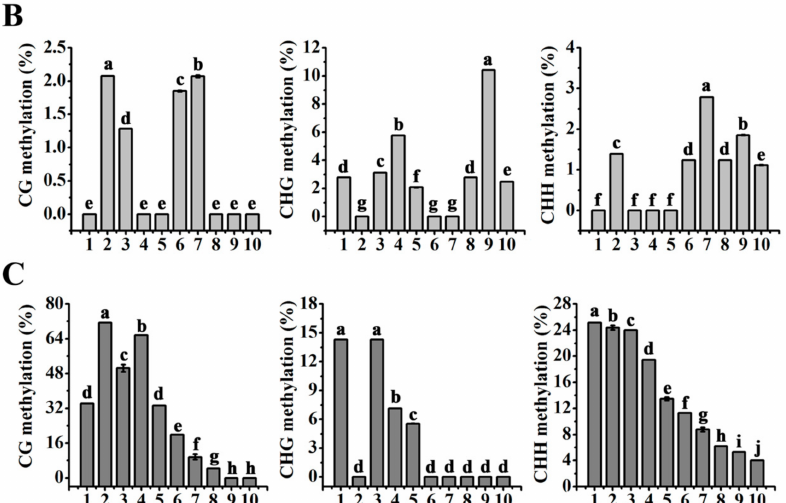
Figure 2. McCOP1 promoter methylation level in crabapple leaves. ( A ). The positions of BP1 and BP2 primers in the McCOP1 promoter. ( B ). McCOP1 promoter methylation level determined using the BP1 primers. ( C ). McCOP1 promoter methylation level determined using the BP2 primers. The numbers 1–10 represent different leaf growth stages. ( D ). Correlation between the McCOP1 promoter methylation levels and McCOP1 gene RNA expression profiles in crabapple leaves visualized as a heat map. Methylation assays were performed with three biological replicates. Error bars indicate the standard error of the mean ± SE of three replicate measurements. Different letters above the bars indicate significantly different values ( p < 0.05), calculated using one-way analysis of variance (ANOVA) followed by a Tukey’s multiple range